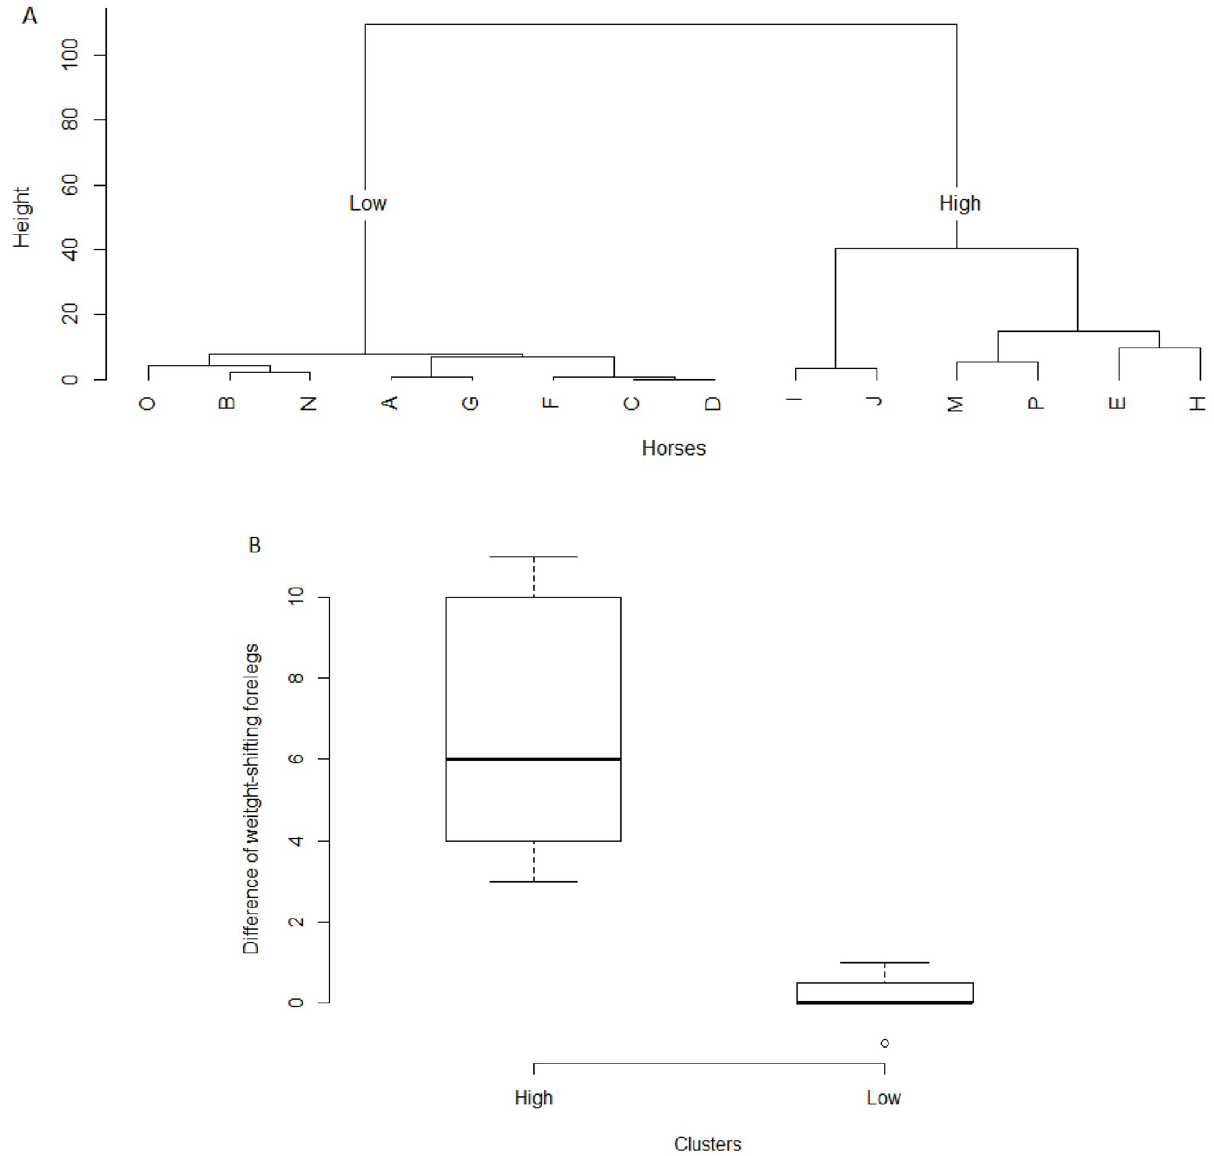
Fig 3. Dendrogram generated through non-hierarchical cluster analysis applied to the difference of weight-shifting forelegs and exercise duration; showing the formation of two clusters, LOW and HIGH (A). Data were assessed pre- and post-workday in 14 ranch horses. Medians of difference of weight-shifting between the forelegs (B) for each cluster (LOW and HIGH) are presented in